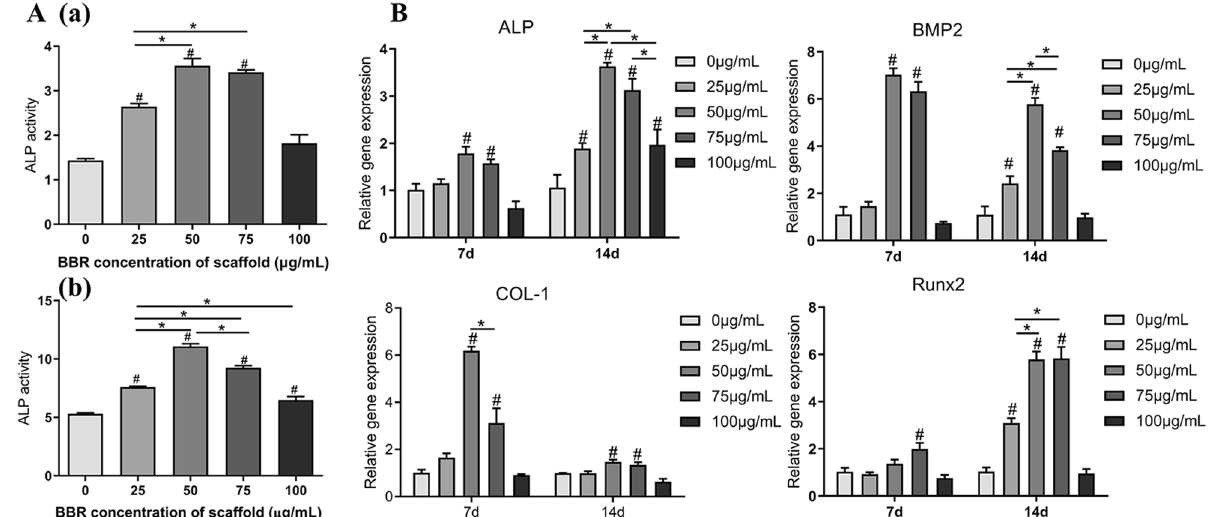
Figure 4. Osteogenic differentiation of DPSCs cultured on scaffolds. ( A ) ALP activity of DPSCs co-cultured on scaffolds after 7 days ( a ) and 14 days ( b ). ( B ) Gene expressions of ALP, BMP2, COL-1, Runx2 in DPSCs co-cultured on the scaffolds after 7 days and 14 days. “#” means the comparison between the control group and the experimental group, P < 0.05; “*” means the comparison between experimental groups, P < effect was not concentration dependent. The content of ALP in all BBR/PCL/COL groups were higher than that in the PCL/COL scaffold on day 14, and the activity of ALP was most significant in the 50 μg/mL scaffold group (11.07 ± 0.32 U/mL) ( P < 0.05). The results of ALP staining (Fig. S1 in the supplementary information) showed that compared with the PCL/COL scaffold, all BBR/PCL/COL scaffolds showed larger and darker purple-blue precipitates, of which 50 ug/mL BBR/ PCL/COL scaffold had the most prominent staining. Moreover, compared with the staining results of 7 days, significantly denser nodules were observed at 14 days in all groups. ALP stain- ing results were consistent with ALP activity. Moreover, we further used Real-time polymerase chain reaction (RT-PCR) to evaluate the expression level of osteogenic genes (ALP, BMP2, OCN and COL-1) of DPSCs, Fig. 4B. On day 7, 50 μg/mL scaffold group showed 1.78 ± 0.20-fold, 6.19 ± 0.23-fold higher expression of the genes associated with early differentiation of bone differentiation, ALP, COL-1, than the PCL/COL group. The expression of ALP in 75 μg/mL scaffold group also showed an up-fold of 1.57 ± 0.11-fold than control. The expression of BMP2 of DPSCs cultured on 50, 75 μg/mL scaffold group was respectively 7.03 ± 0.34-fold and 6.32 ± 0.55-fold higher than in the control. However, there was no statistical difference between the two groups. On day 14, the expression of ALP in all BBR/PCL/COL scaf- folds were significantly increased (1.89 ± 0.15-fold, 3.63 ± 0.10-fold, 3.13 ± 0.34-fold and 1.97 ± 0.42-fold higher), and the 50, 75 μg/mL scaffold groups were more significantly than 25, 100 μg/mL groups ( P < 0.05). BMP2 and Runx2 was increased in the 25, 50 and 75 μg /mL groups, with the most significant up-regulation in 50 μg/mL. Bone repair potential in vivo. To evaluate the in vivo bone repair ability of the scaffold, PCL/COL scaf- fold and BBR/PCL/COL scaffolds were implanted to the prepared critical bone defects. None of the rats showed significant inflammation or immune response after surgery. The skulls were harvested at 4 weeks and 8 weeks for micro-CT evaluation. Bone defect area was marked with dashed lines in Fig. 5. At 4 weeks, there was almost no new bone formation in the control group, and only a limited amount of mineralized deposits was found in the marginal area of the defect (Fig. 5A). In the Bio-oss group, the defect was filled with bone powder, part of the powder was displaced (Fig. 5B). The scaffolds provided support for new bone formation. In PCL/COL scaffold group, moderate mineral deposits were found in the center and edges of the defect (Fig. 5C). The mineralized area of BBR/PCL/COL scaffold group was larger than PCL/COL scaffold group (Fig. 5D). With time going on, the defect area was gradually repaired by newly formed minerals. At 8 weeks, the mineralization of the control group extended to the center, however the center of defect remained empty (Fig. 5E). In the Bio-oss group, the defect was still filled with bone powder, while the mineralization connected to the defect margin were more abundant (Fig. 5F). Compared with 4 weeks, the mineralization in the PCL/COL scaffold group increased significantly in 8 weeks, with limited defects still open (Fig. 5G). Surprisingly, the defect in the BBR/PCL/COL scaffold group was almost repaired by newly formed minerals (Fig. 5H). Meanwhile, in order to quantify the mineralization of newly formed tissue in the defect area, bone mineral density (BMD), bone volume/tissue volume (BV/TV), tra- becular number (Tb. N) and trabecular thickness (Tb. Th) were analyzed (Fig. 6). At 8 weeks, compared to the control group, BBR/PCL/COL scaffold group showed higher bone mineral density ( P = 0.03) and the BV/TV was also significantly increased ( P = 0.03). At 8 weeks, the number of trabeculae and the thickness of trabeculae in the BBR/PCL/COL scaffold group increased compared to the control and PCL/COL scaffold group, although there was no significant difference. However, the results of Bio-oss group were false high due to the undegraded bone powder, which could not be avoided during measurement. Combined with the results of histological analysis, the high mineralization in the defect area was mostly caused by bone powder, and limited new bone was formed.